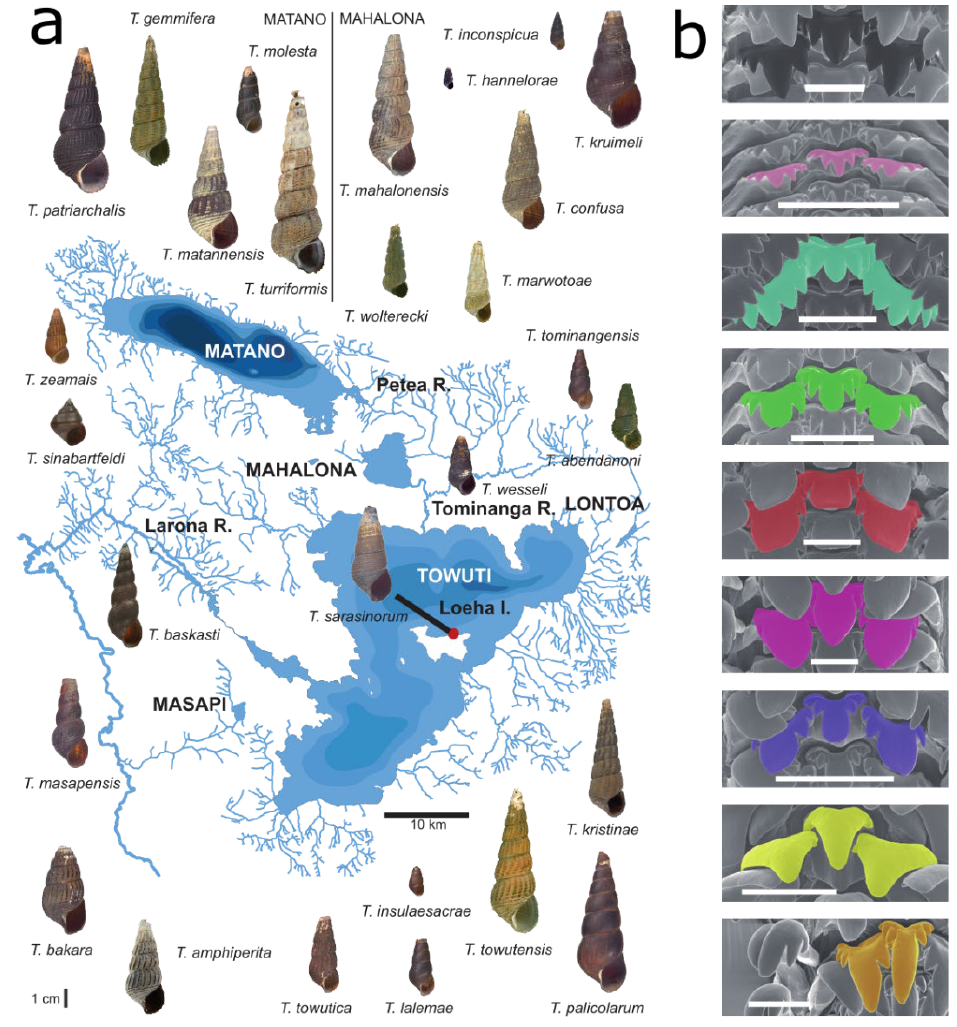
Figure 1. Diversity of Tylomelania in the Malili Lakes. Species diversity in the Malili Lakes and surrounding rivers ( a ) is shown together with an overview of radula morphologies ( b ) (Scale bars = 0.1 mm). The sampling site of T. sarasinorum at Loeha Island is indicated by a red dot. Modified with permission from [24,25] (8 June 2022, Springer